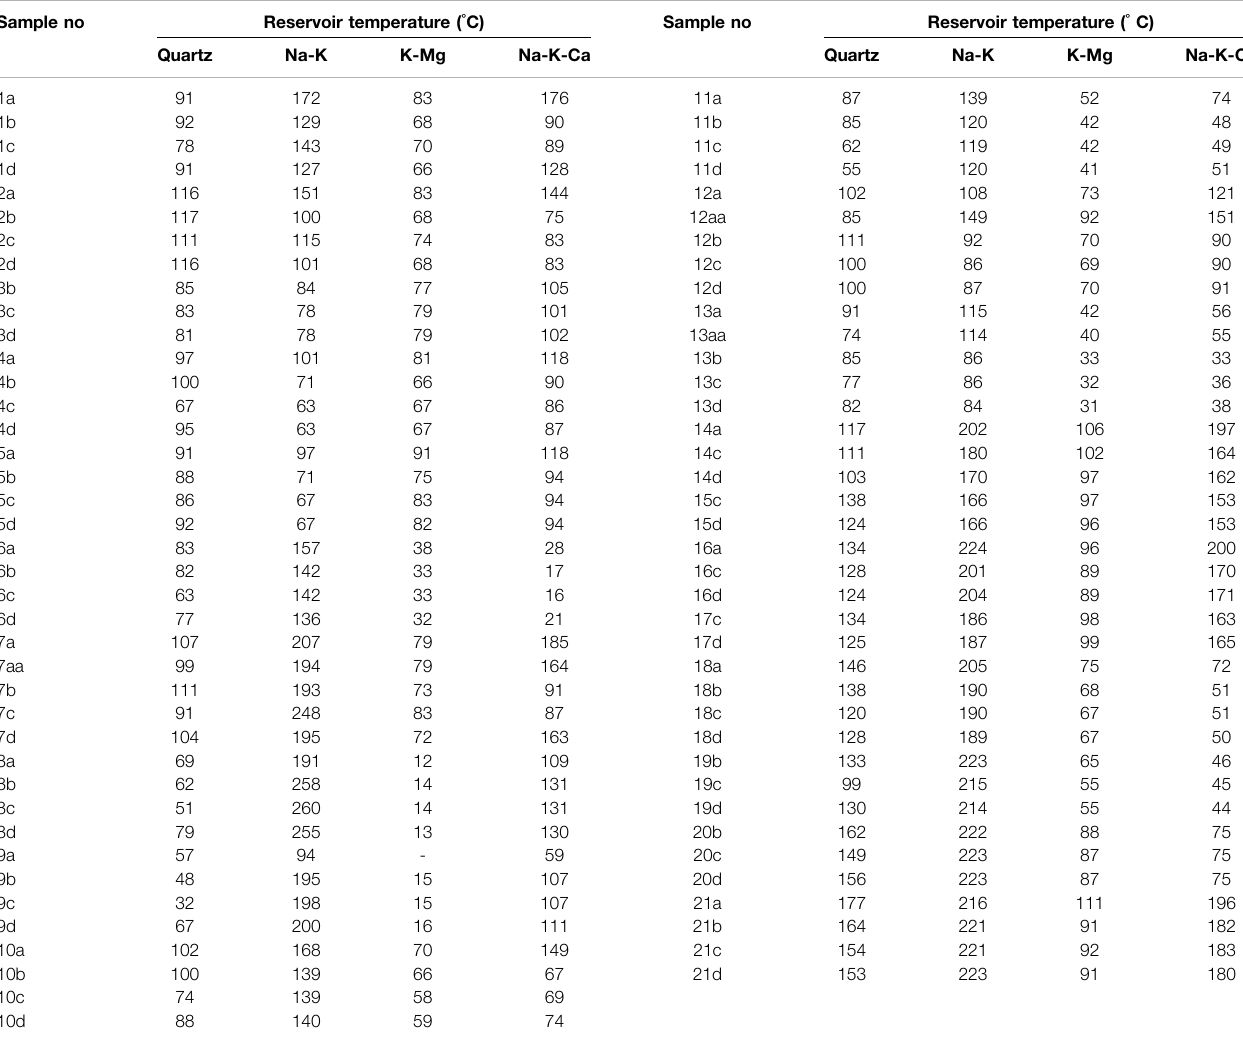
TABLE 1 | The estimated reservoir temperatures of hot springs in the Simao